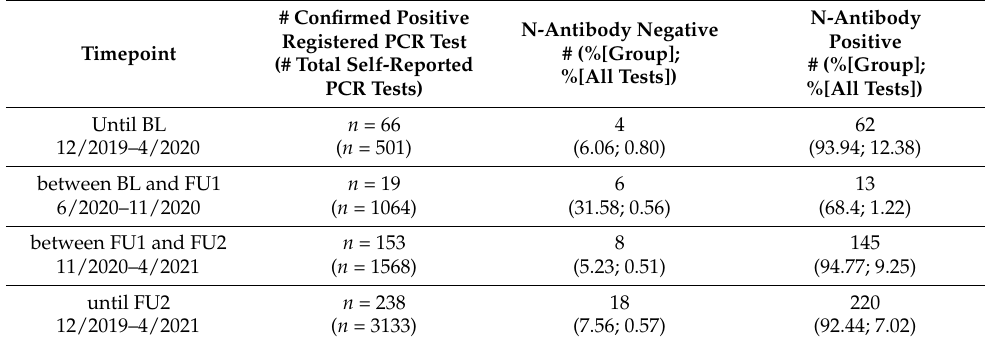
Table 3. PCR-test report. Via questionnaire, 66, 19 and 153 participants reported a positive PCR-test for the period until BL, between BL and FU1, or between FU1 and FU2, respectively, which were confirmed by health authorities. We derived the % N-antibody negatives and N-antibody positives at BL, FU1, FU2, respectively, for these individuals. Additionally, we derived the % N-antibody negatives and N-antibody positives at FU2 for all individuals with self-reported positive PCR-test (health authority confirmed) at any time until FU2 assessment (April